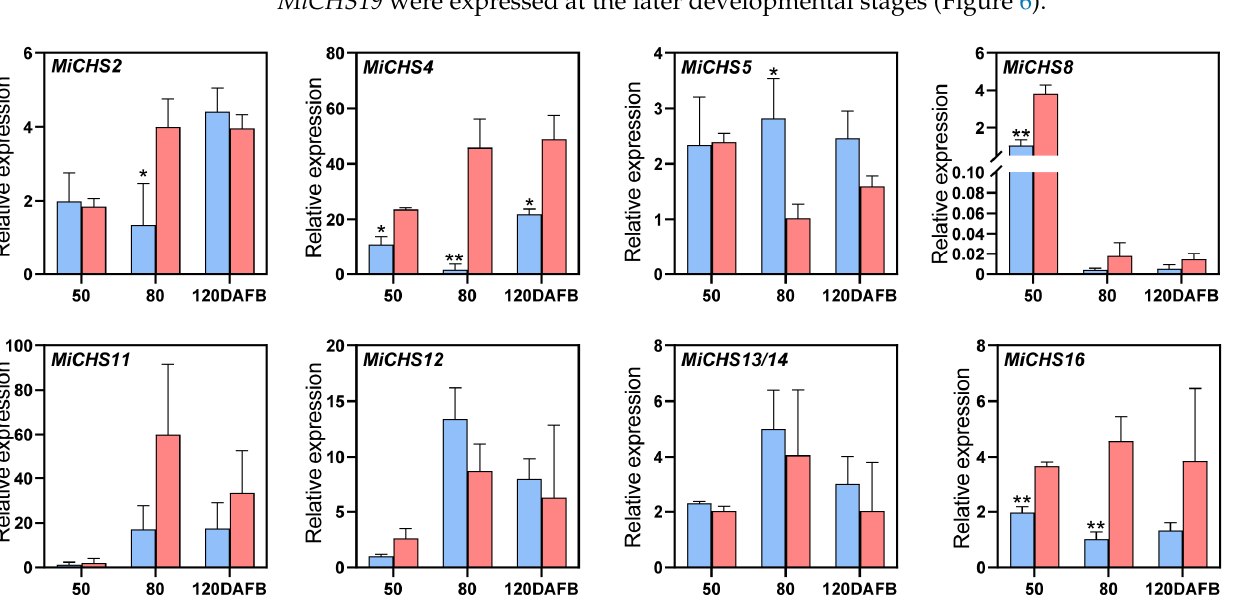
Figure 6. Expression profiles of MiCHS genes during the bagging treatment. Bagged (blue bars) and control (red bars) ‘Sensation’ mango peels were collected at 50, 80 and 120 DAFB. The data represent the mean value ± SD, n = 3. * indicates a significant difference ( p -value < 0.05). ** indicates a very significant difference ( p -value < 0.01), as determined by Student’s t -test. During the postharvest UV-B/visible light treatment, the transcriptions of MiCHS4 , MiCHS16 and MiCHS17 were also up-regulated, while the response pattern was different (Figure 7). The response of MiCHS17 to light lasted for almost the whole period of treat- ment (Figure 7). The responses of MiCHS4 and MiCHS16 to light occurred at the middle and late stages (144H and 240H) and early and late stages (6H, 24H and 240H) of light treatment, respectively (Figure 7). The expression of MiCHS11 was also induced by light at 24H and 240H, while the rest of the genes did not an show obvious responsive pattern to the postharvest UV-B/visible light treatment (Figure 7).